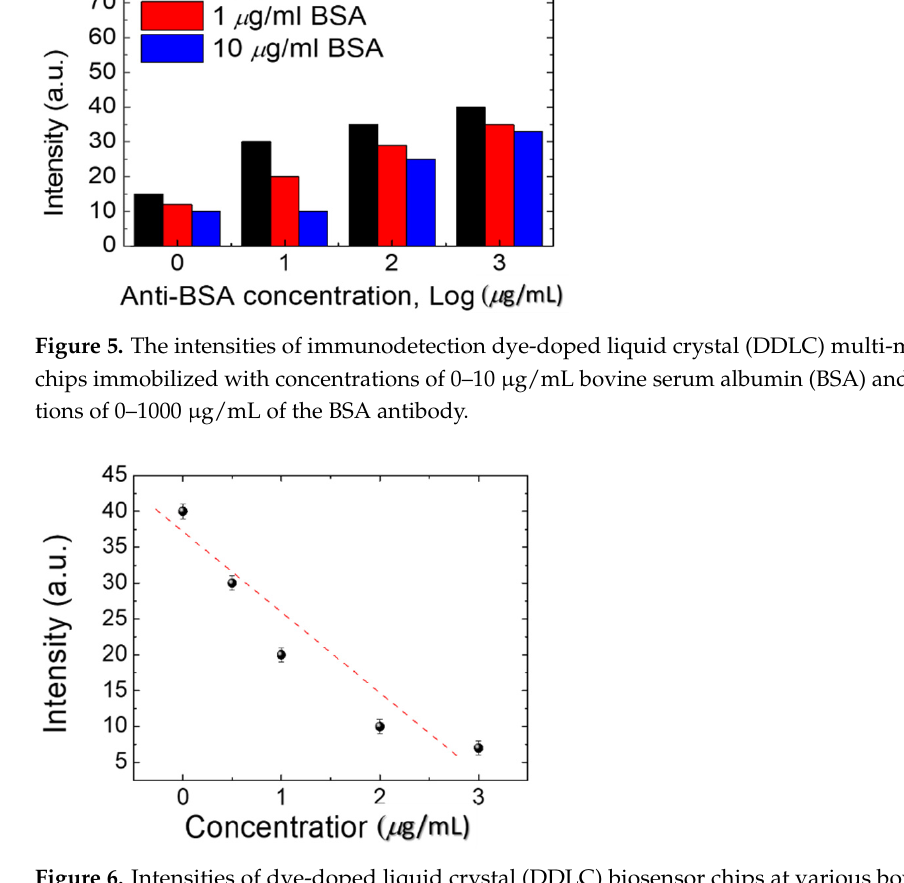
Figure 6. Intensities of dye-doped liquid crystal (DDLC) biosensor chips at various bovine serum albumin (BSA) with a 1 µg/mL of BSA antibody.